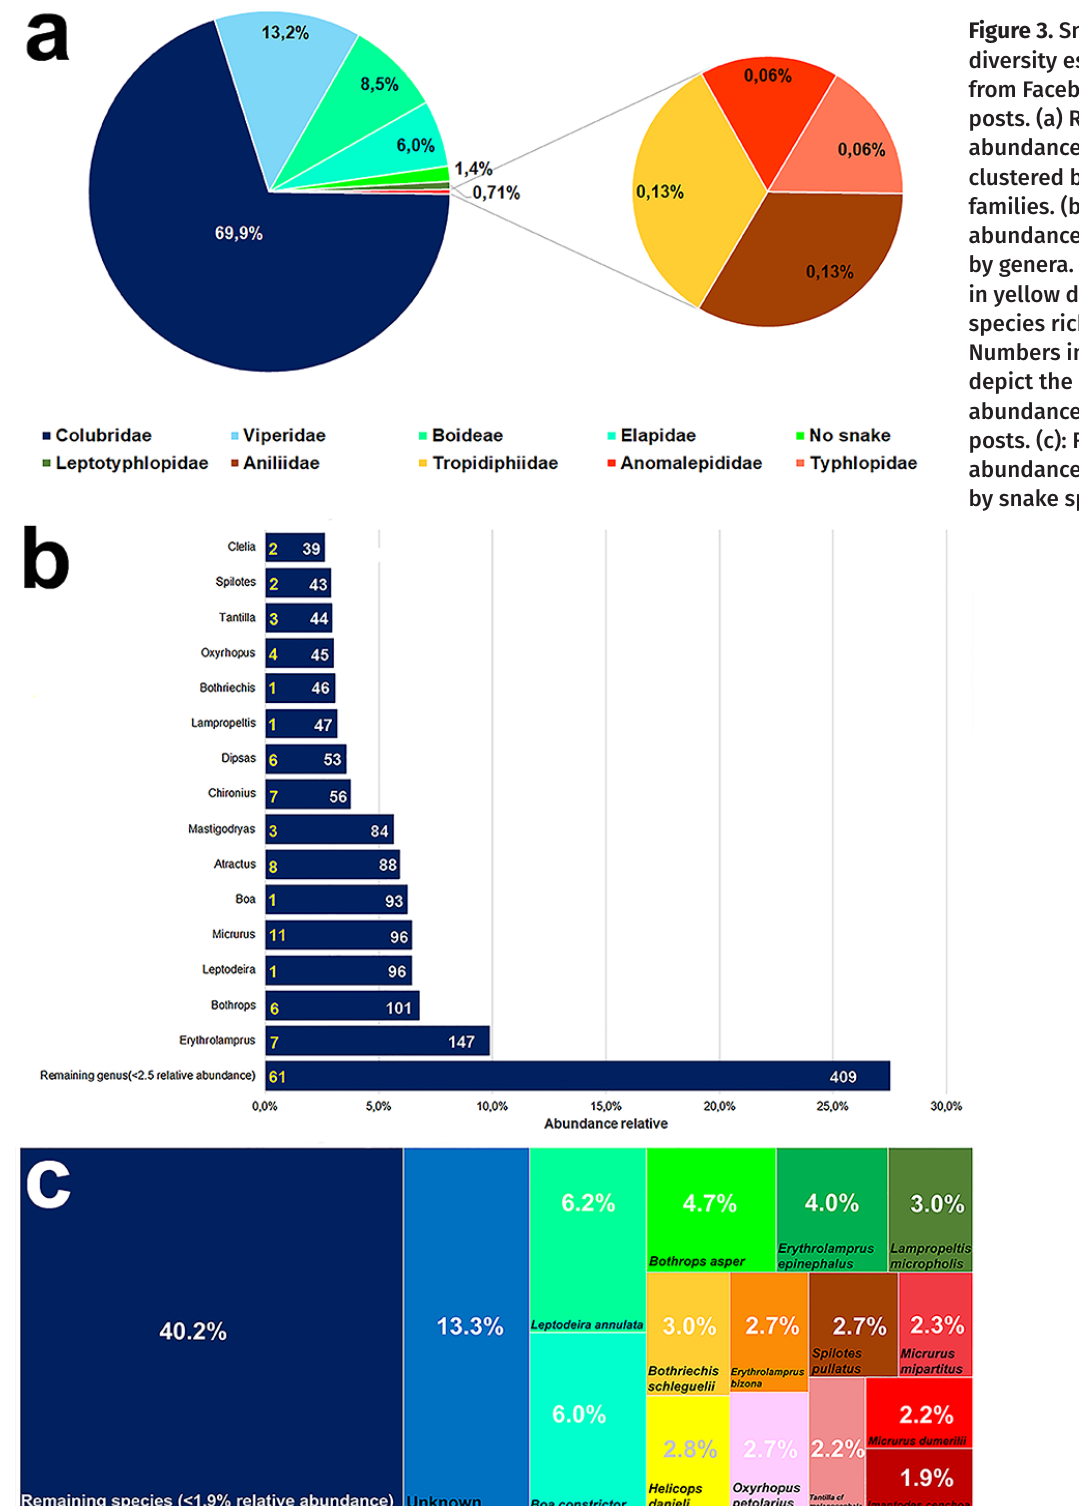
Figure 3. Snake diversity estimated from Facebook posts. (a) Relative abundance of posts clustered by snake families. (b) Relative abundance of posts by genera. Numbers in yellow depict species richness. Numbers in white depict the absolute abundance of posts. (c): Relative abundance of posts by snake